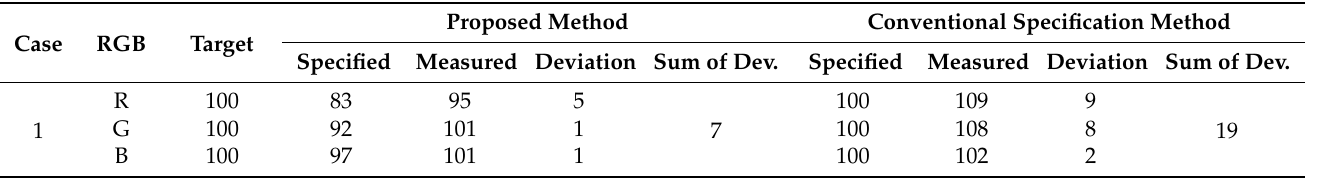
Table 4. Comparison of deviations of measured RGB values on printed samples from the target RGB values using the proposed method versus the conventional specification method without compensation. Proposed Case RGB Target